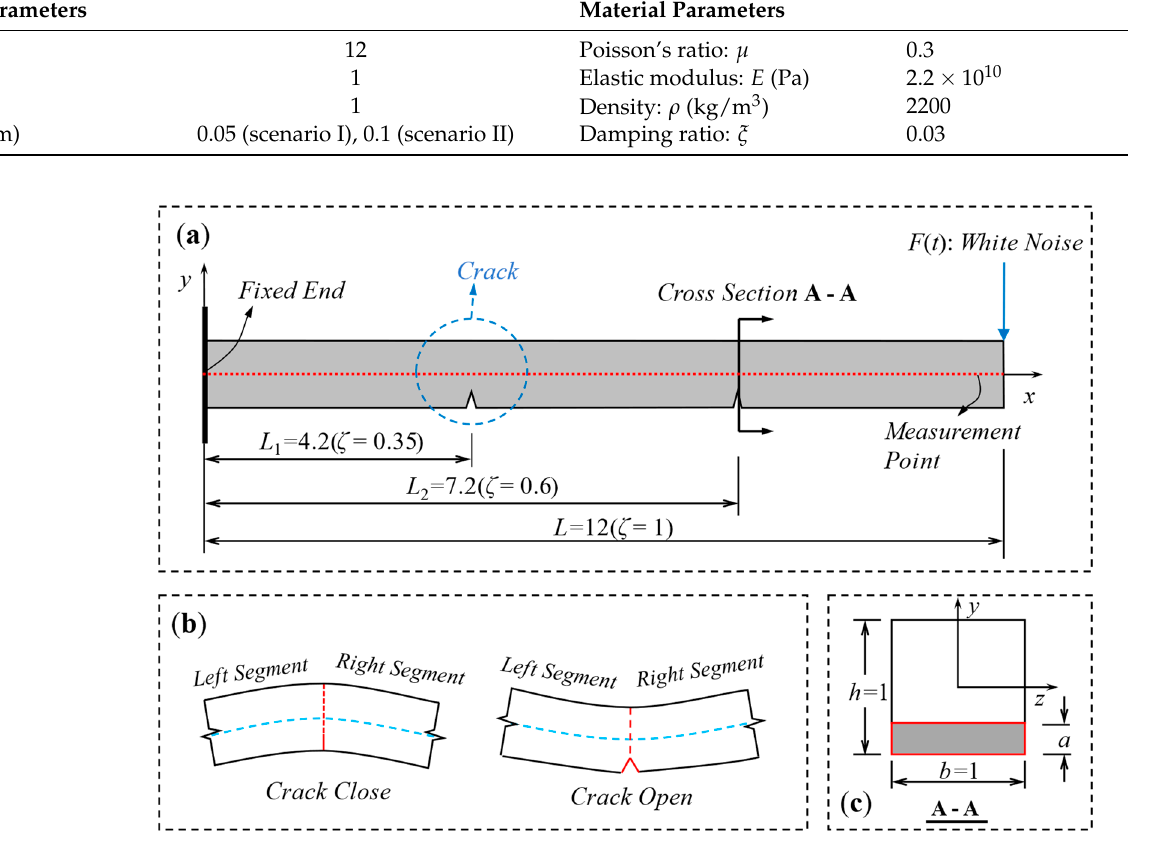
Figure 6. Gaussian white noise time history. Figure 7. Strain response of cracked cantilever beam under scenario I. 0